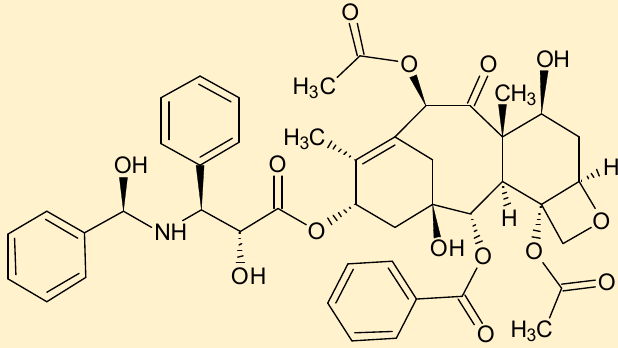
Figure 2. Taxol, the first compound isolated from an endophytic fungus from Rubiaceae.